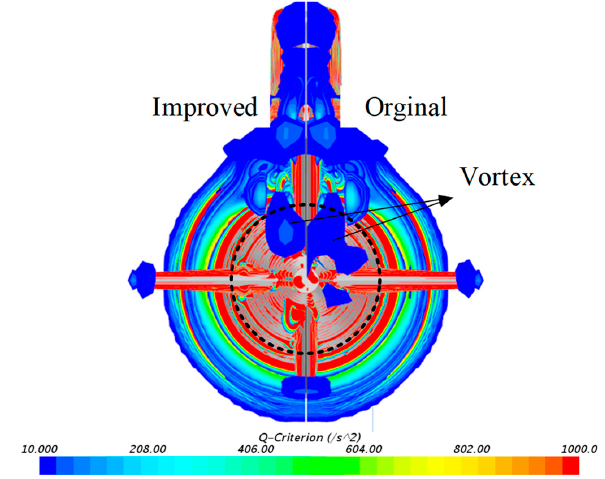
Figure 9. The Q-criterion contour around the submarine.